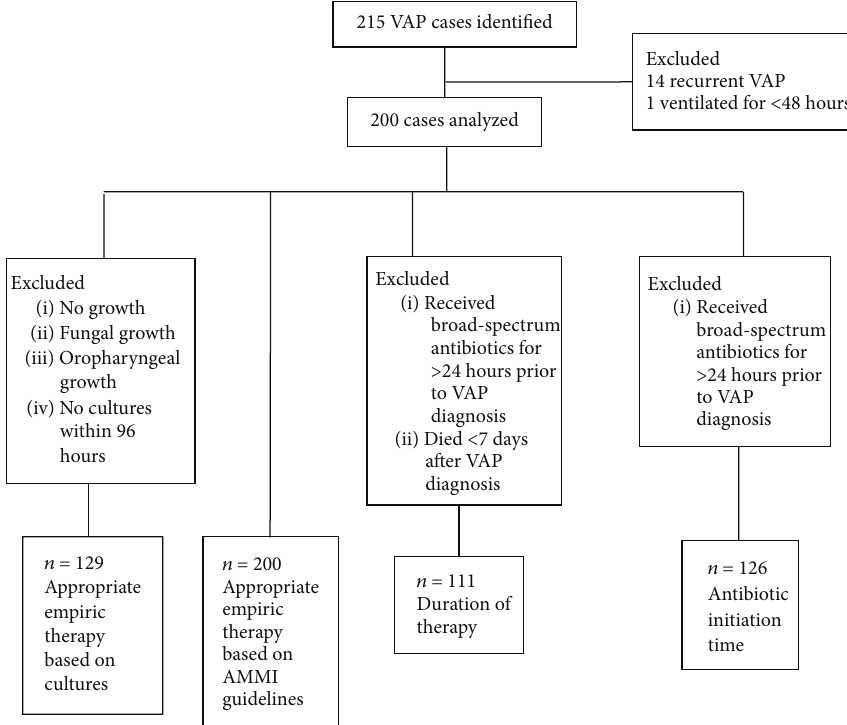
Figure 1: Study participants and analysis